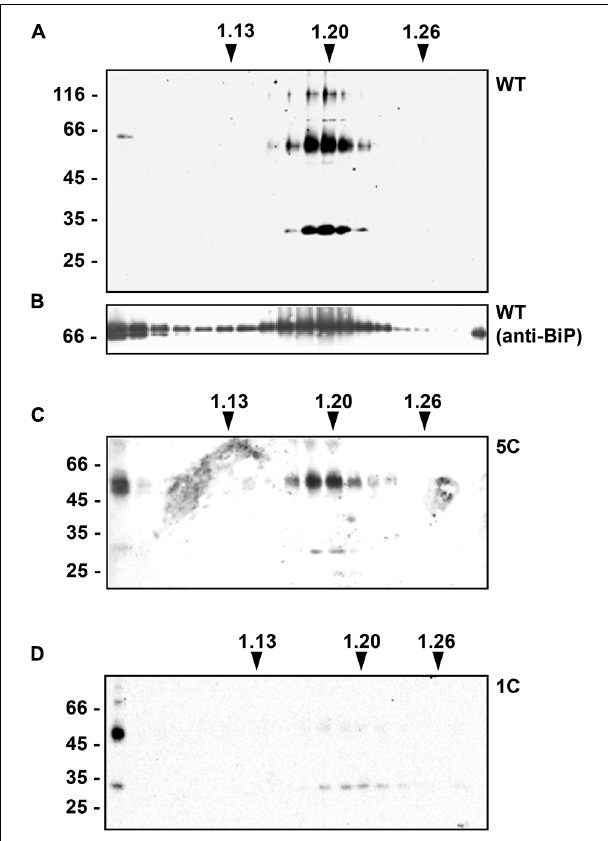
FIGURE 3 | Subcellular distribution of the different γ -zein constructs. Tobacco protoplasts were transfected with plasmid encodingWT γ -zein (A,B) , 5C- γ -zein (C) or 1C- γ -zein (D) . After 24 h incubation, protoplasts were homogenated in oxidizing conditions, in the absence of detergent and presence of sucrose. Homogenates were fractionated by isopycnic ultracentrifugation on sucrose density gradients. Equal amounts of each gradient fraction were analyzed by SDS-PAGE and protein blot using anti-flag (A,C,D) or anti-BiP (B) antiserum. Numbers on top indicate fraction density (g/ml). In each panel, numbers at left indicate the positions of molecular mass markers, in kD. are in part delivered to the vacuole. Protoplasts were subjected